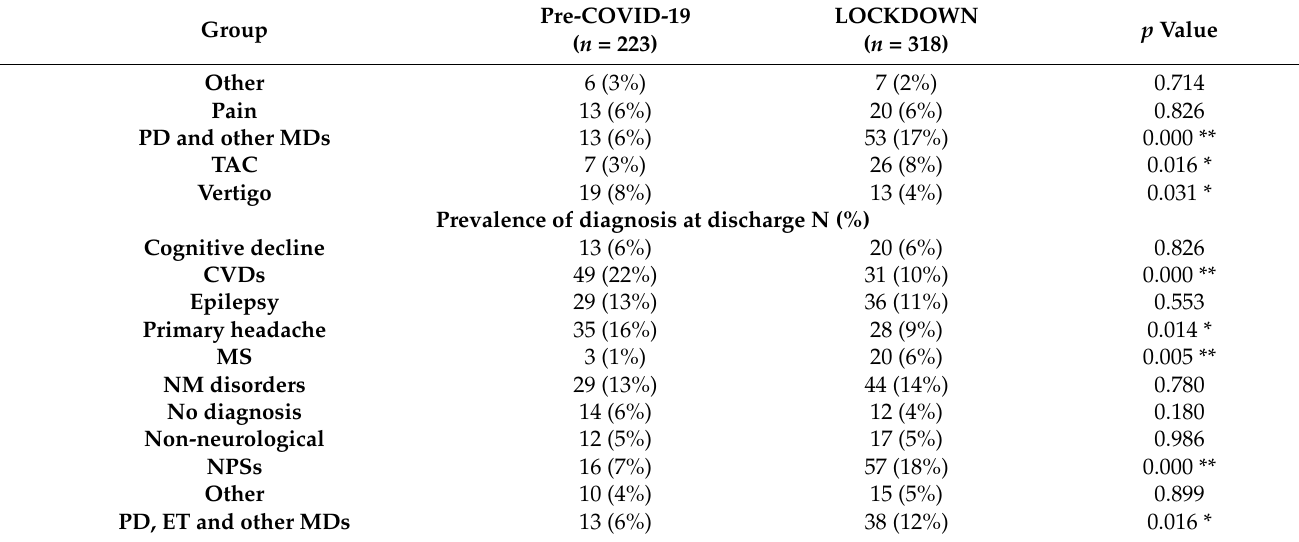
Figure 1 details sample selection, patients’ access and reasons for requesting the non-deferrable neurological evaluation.